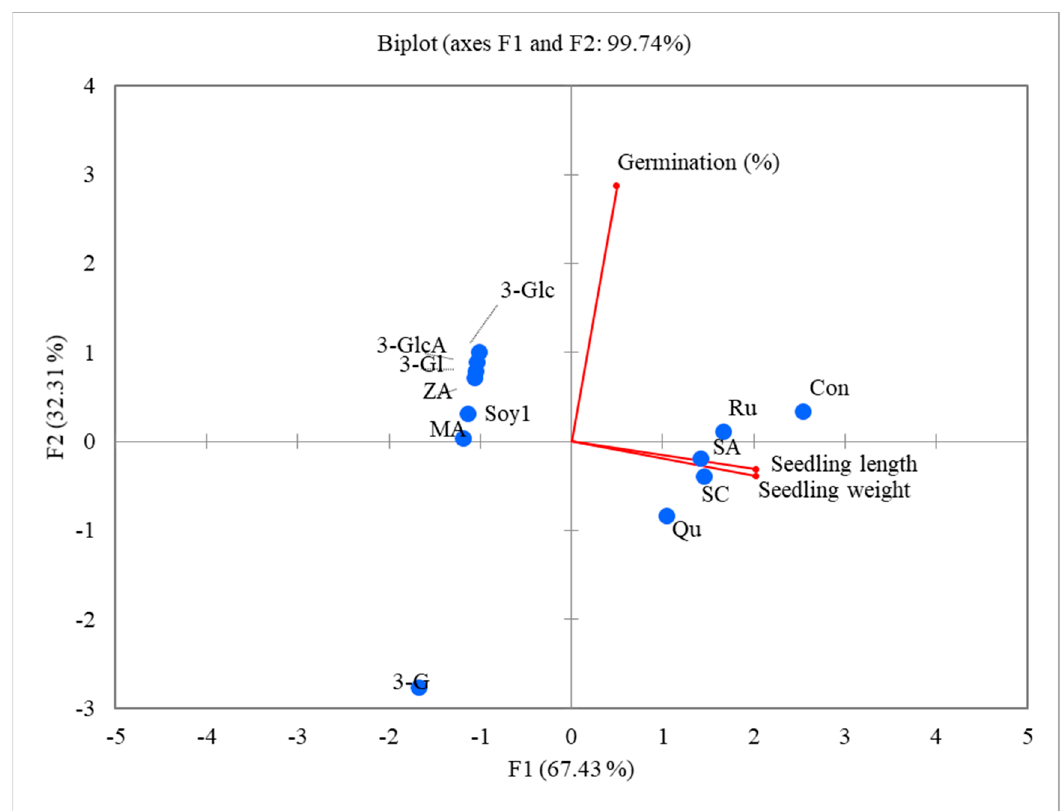
Figure 8. Principal composition analysis (PCA) biplot constructed by plotting the PC1 (vertical axis) scores against the PC2 (horizontal axis) scores obtained from phenolic compounds and saponins. MA: Medicagenic acid; Soy1: Soyasaponin I; 3G: 3-Glc-Glc, 28 AraRhaXyl medicagenic acid; 3-Gl: 3-Glc, 28-Glc medicagenic acid; 3-Glc: 3-Glc, 28 AraRhaXyl medicagenic acid; 3-GlcA: 3-GlcA, 28 AraRha medicagenic acid; ZA: Zanhic acid tridesmoside; Ru: Rutin; SA: Salicylic acid; SC: Scopoletin; Qu: